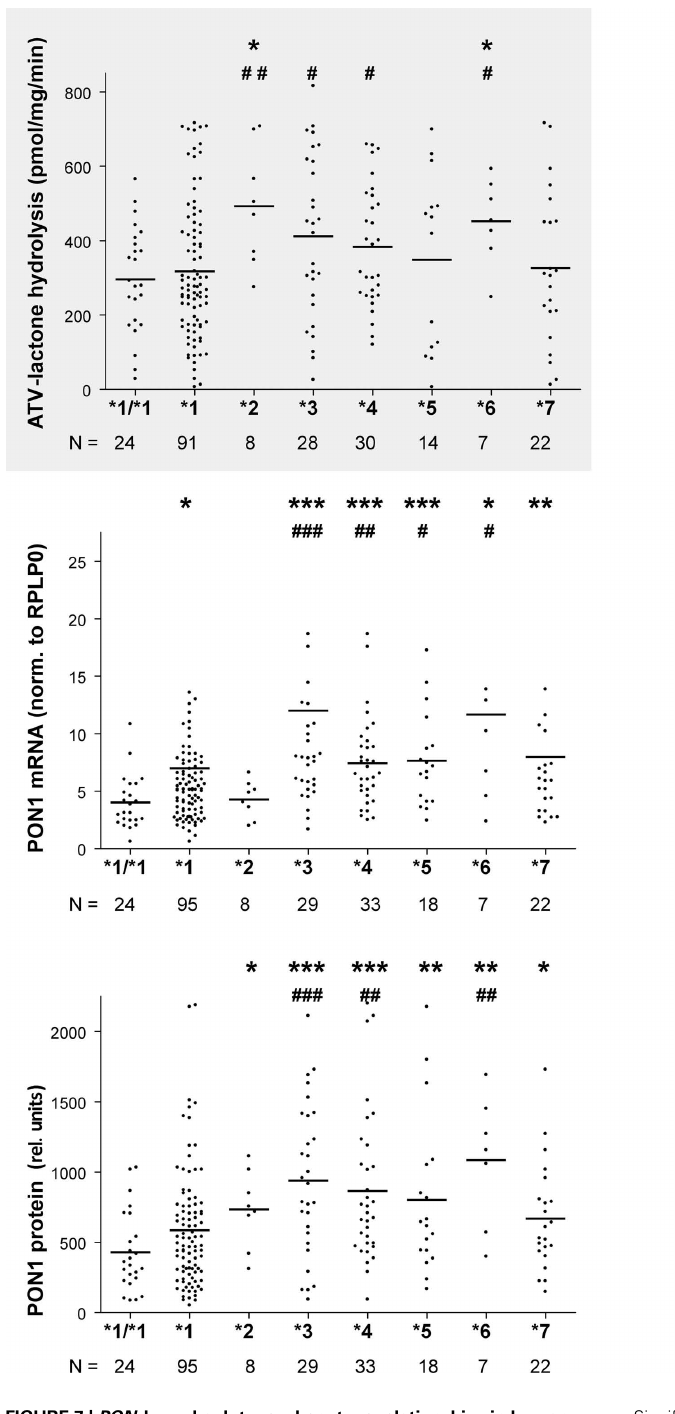
FIGURE 7 | PON -locus haplotype–phenotype relationships in human liver. Atorvastatin-lactone hydrolysis, PON1 and PON3 mRNA and microsomal protein are displayed for the indicated haplotypes. Horizontal lines indicate the median.Wilcoxon–Mann–Whitney-tests were applied to compare *2 to *7 carriers with *1 / *1 (marked by *) or *1 carriers (marked by #).